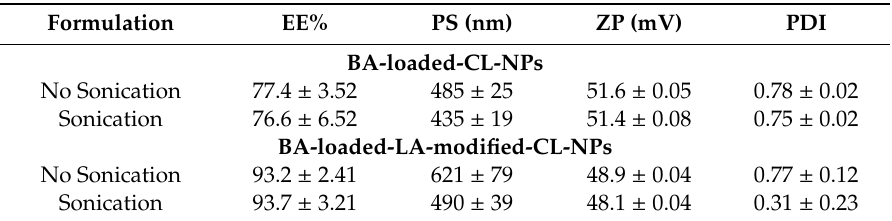
Table 3. E ff ect of sonication on EE%, PS, and ZP of LA-free NPs and LA-modified NPs.